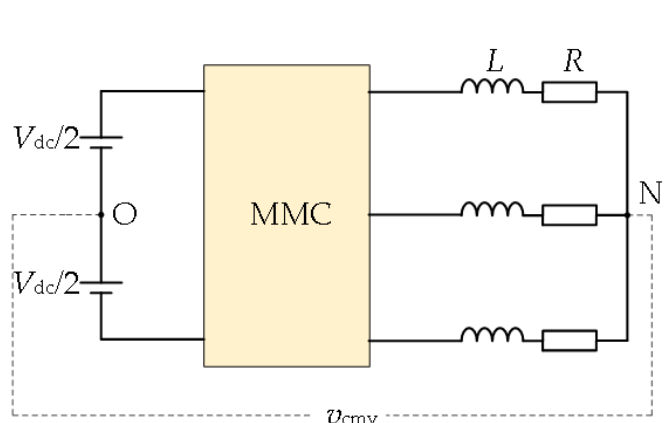
Figure 2. The common mode voltage of MMC.